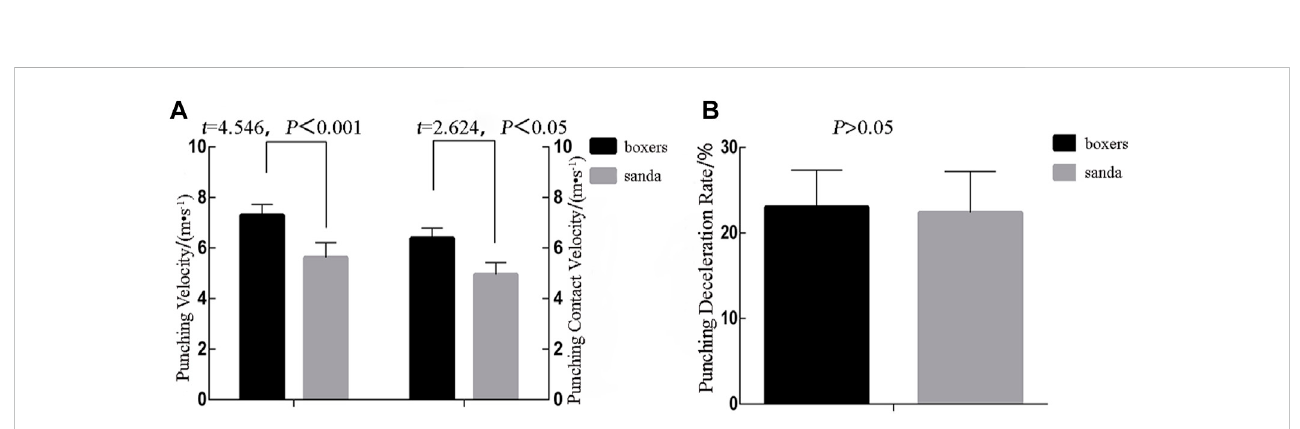
FIGURE 4 (A) punching velocity and contact velocity of straight punches for boxing and Sanda; (B) percentage decay of punching